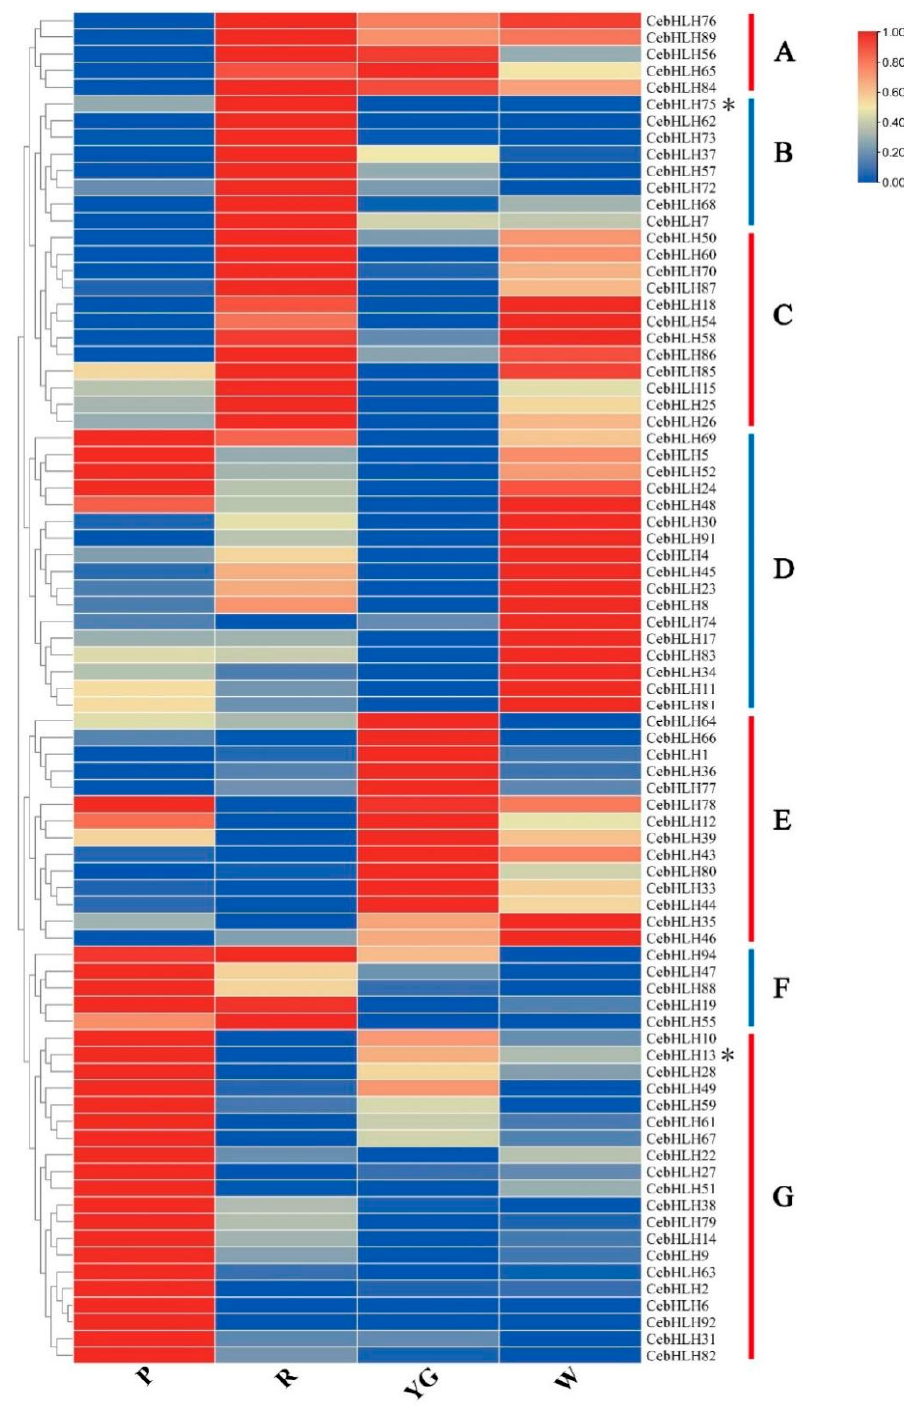
Figure 7. Expression patterns of 82 CebHLHs were divided into seven groups (A–G). P stands for purple-red sepals; R stands for red sepals; YG stands for yellow-green sepals; W stands for white sepals. * denotes CebHLH13 and CebHLH75 of the S7